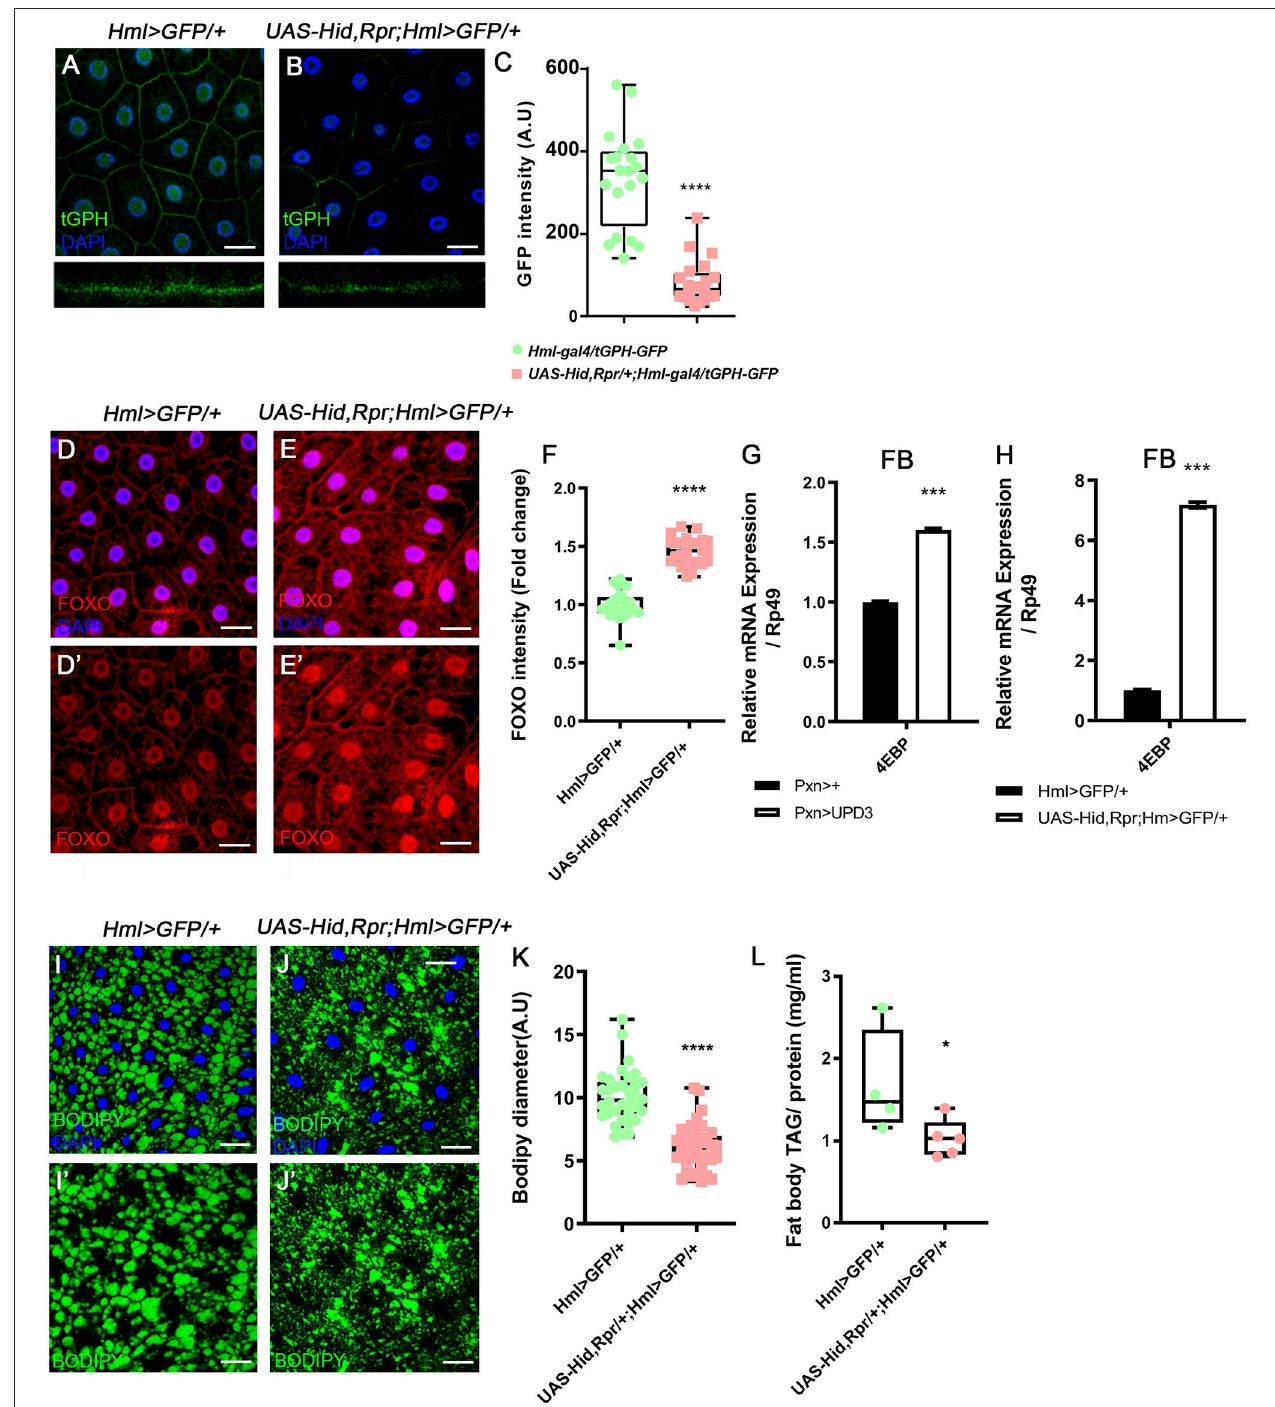
FIGURE 3 | Attenuated insulin signaling in the fat body upon loss of Hml + hemocytes. (A–C) Membrane localization of t GPH, a reporter for PI3K activity, is reduced by ablating Hml + hemocytes. Fat body isolated from wild types exhibits membrane-expression of t GPH (green) (A) , whereas this pattern disappears in Hml-Gal4 UAS-hid,rpr background (B) . Bottom images indicate magnified Z-stacks of corresponding images. Quantitation of t GPH expression in the fat body membrane (C) . DAPI, blue. Scale bar, 40 µ m. Statistical significance was determined by t-test . **** p < 0.0001. (D–F) Expression of dFOXO upon genetic ablation of Hml + hemocytes. Cytosolic and low expressions of dFOXO in the wild-type fat body (D,D’) . The level and nuclear localization of dFOXO is enhanced in Hml-Gal4 UAS-hid,rpr background (E,E’) . DAPI (blue) and dFOXO (red) are overlaid in (D,E) , and dFOXO (red) alone is shown in (D’,E’) . Nuclear dFOXO levels are quantitated in (F) .